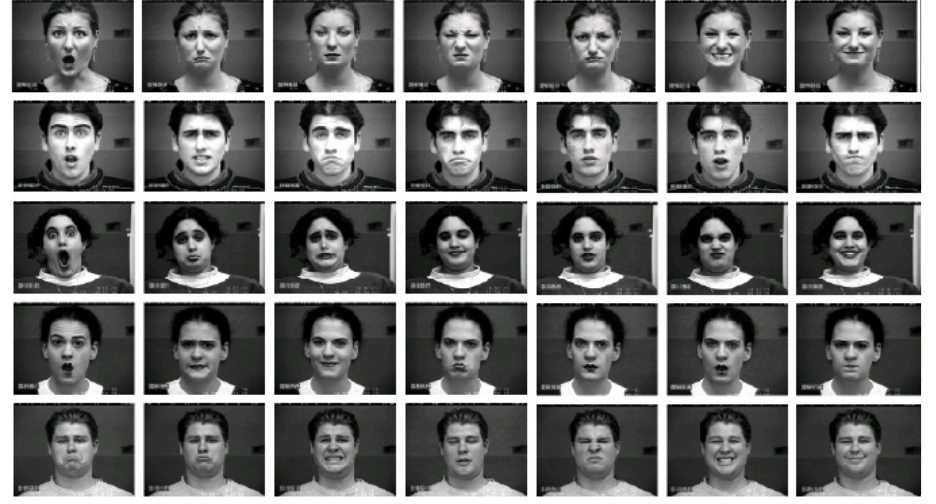
Figure 4. Examples of facial expression images from the Cohn-Kanade